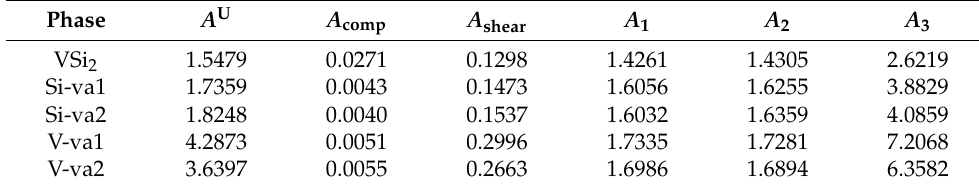
Table 5. Calculated elastic anisotropy indeces of C11 b -VSi 2